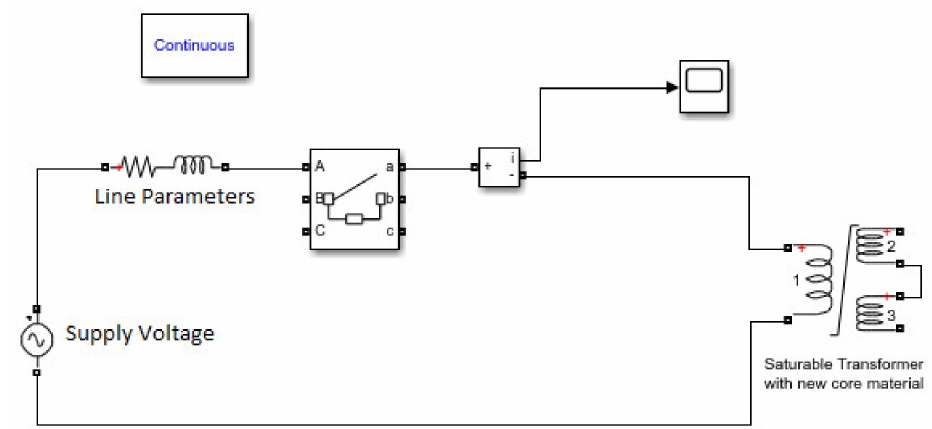
Figure 8. Representation of energization inrush